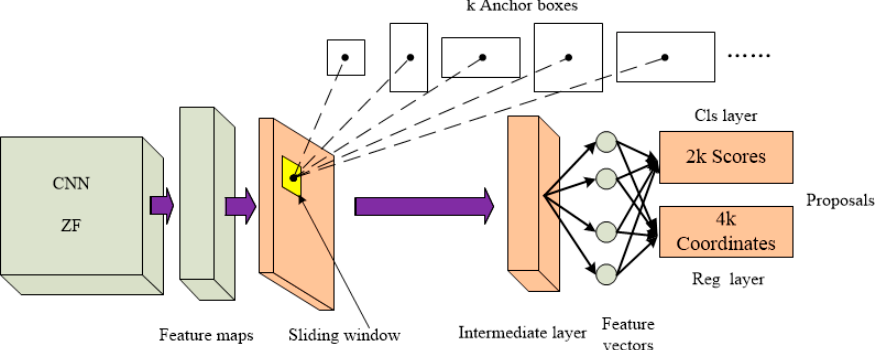
Figure 7. The structure of the improved region proposal network (RPN).